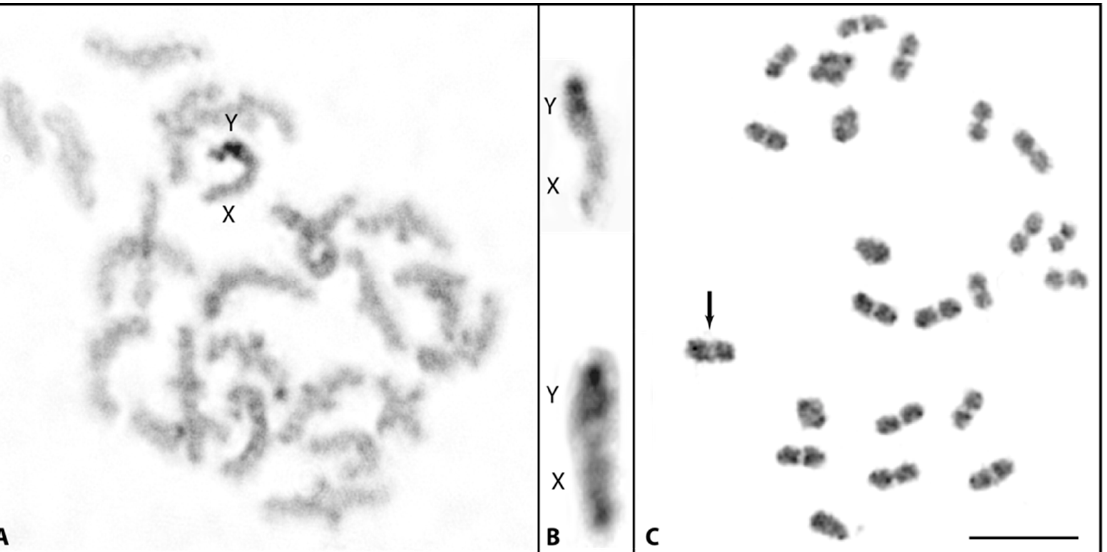
Figure 4. C-banded meiotic guppy chromosomes. Diakinesis-metaphase I ( A ) and XY cut-outs ( B ) of M. picta showing end-to-end association between the X and Y during meiosis. ( C ) Metaphase I of Poecilia wingei (LP strain). Note the association between the X and Y (arrow) appears to be similar with autosomal bivalents. Bar: 3 µm.